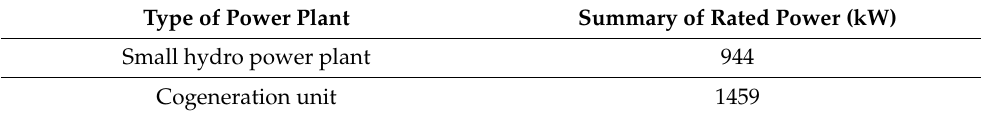
Table 1. Summary of power plants.